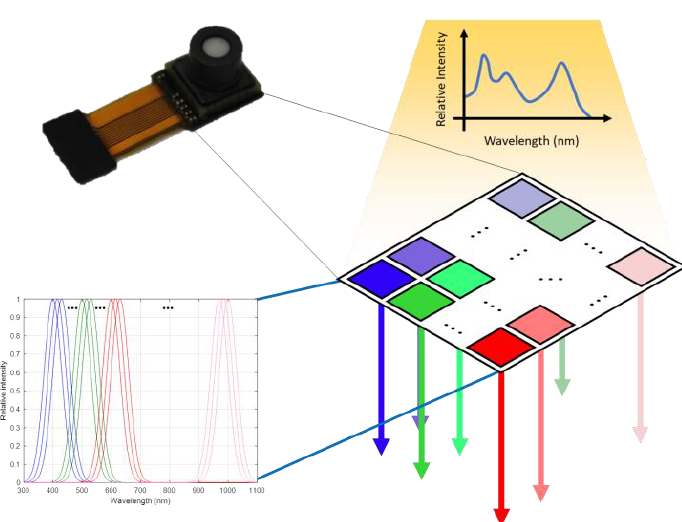
Figure 7. Structure of the used chip-scale spectrometer.